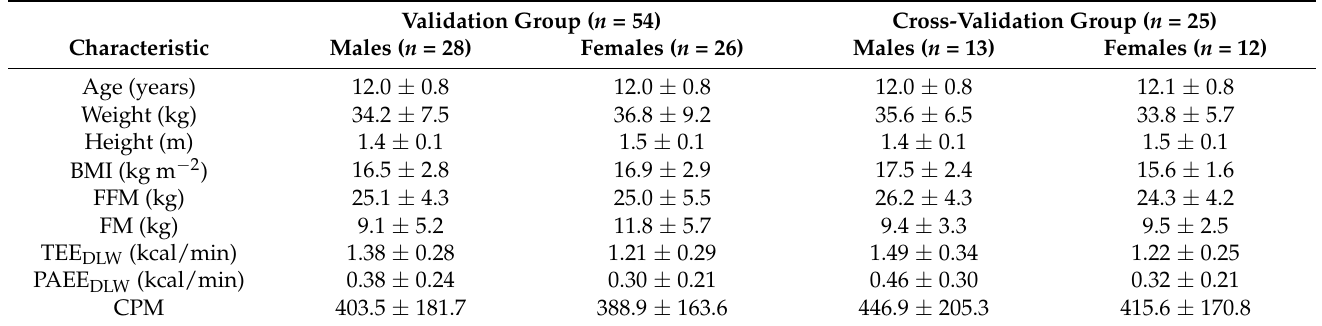
Table 1. Basic demographic and anthropometric parameters of validation and cross-validation groups by